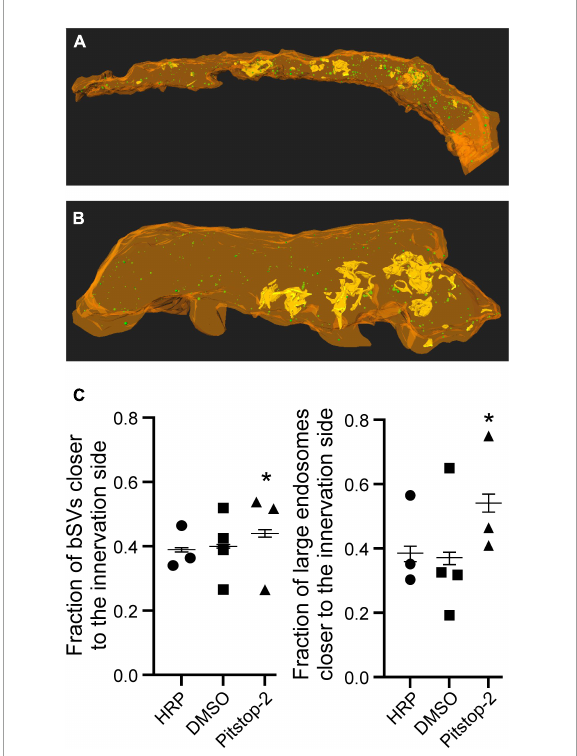
FIGURE6 Application of Pitstop-2 alters the localization of large endosomes and bSVs at the calyx of Held. (A) 3D reconstruction of the endocytic compartments in the absence of Pitstop-2. (B) 3D reconstruction of the endocytic compartments in the presence of Pitstop-2. PM appears in orange, large endosomes are depicted in yellow and bSVs as green spheres. The innervation side is facing the bottom. (C) Quantification of the effects of Pitstop-2 on the localization of bSVs (left) and large endosomes (right) Please note that the weighted means are depicted. ( n = 3–4 calyces/group, 1 calyx/animal; * = p < 0.05, Pitstop-2 different from both control